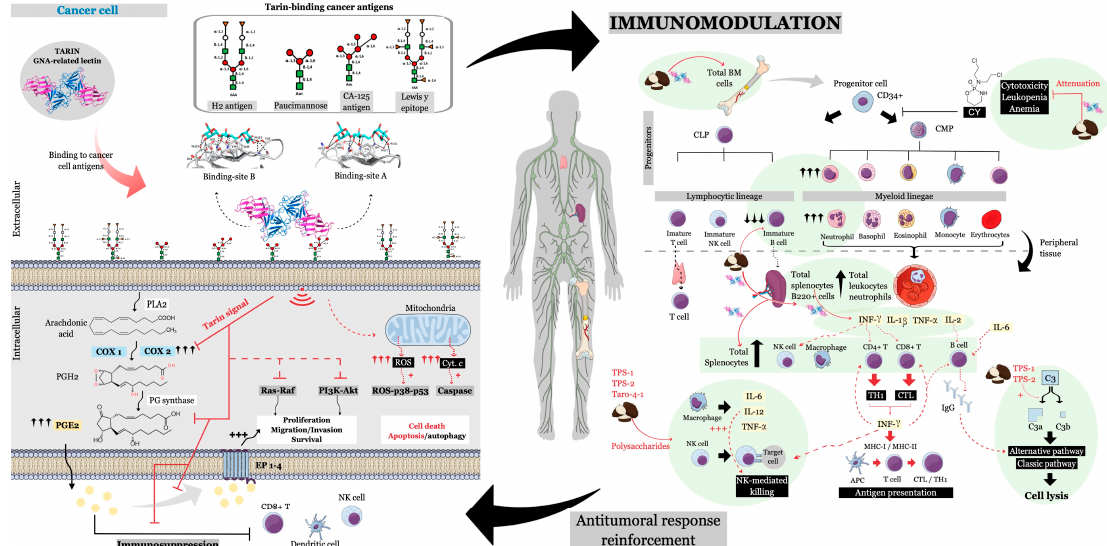
Figure 4. Hypothetical antitumoral tarin mechanism. ( left-hand panel ) Tarin binds to specific carbohydrate antigens, typically overexpressed in cancer cells, down-regulating COX-2 (cyclooxygenase 2) expression, culminating in decreased PGE2 (prostaglandin 2) synthesis and derepression of the antitumoral response. Tumor progression can be inhibited by inactivation of Ras–Raf or PIK3–Akt pathways and cell death by the activation of ROS-p38-p53 or caspase-dependent pathways, inducing apoptosis or autophagy, commonly described for GNA-related lectins. Red lines show already known tarin mechanisms. Dashed red lines indicate the main mechanisms reported for GNA-related lectins. PLA2—phospholipase A2; PG synthase—prostaglandin synthase; ROS—reactive oxygen species; Cyt. c —cytochrome c ; EP1-4—prostaglandin E receptor 1-4; NK cells—natural killer cells. ( right-hand panel ) Anticancer effects may be boosted by the immunomodulatory abilities of tarin and other taro derivatives, whose effects are highlighted in green and include complement activation through alternative and classical pathways, natural killer (NK) cell activation, T cell activation to TCD4+ cells (Th1) and TCD8+ (CTLs—cytotoxic T lymphocytes) effectors, cytokines release by polysaccharide-activated macrophages and tarin- activated splenocytes, progenitor cell protection through the attenuation of cyclophosphamide (CY) cytotoxic effects and the proliferation of spleen and bone marrow cells. Red lines indicate tarin and polysaccharide effects, while the dotted red lines indicate the downstream effects that might be triggered by released cytokines. CLP—common lymphoid progenitor, CMP—common myeloid progenitor, BM—bone